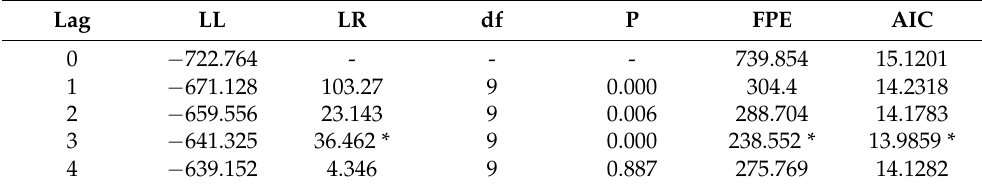
Table 5. Optimal lag length concerning the electricity consumption of the industry sector. Lag